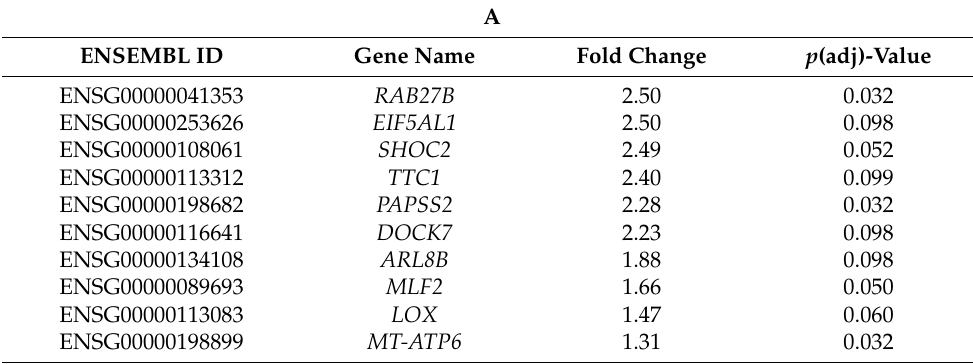
Figure 3. Activin-A induces differential gene expression only in FOP cells. Graphic display of differential gene expression (MA plot) in which the Log2 Fold Change induced by Activin-A treatment is plotted against the mean of normalized counts. Differentially expressed genes ( p (adj) < 0.1) depicted as red dots. ( A ) MA plot of control samples shows no differentially expressed genes. ( B ) MA plot of FOP shows some differential gene expression induced by Activin-A, n = 4 for control and n = 5 for FOP samples. ( C ) Gene expression heatmap from median centered supervised gene expression analysis of the differentially expressed genes in the FOP cells. ( p (adj) < 0.1, Z score is Log2 scale), n = 5. Table 6. ( A ) Upregulated genes by Activin-A in FOP cells. ( B ) Downregulated genes by Activin-A in FOP